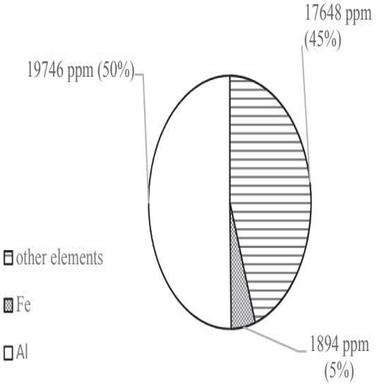
ICP plasma spectroscopy data concentrations of slag sample.